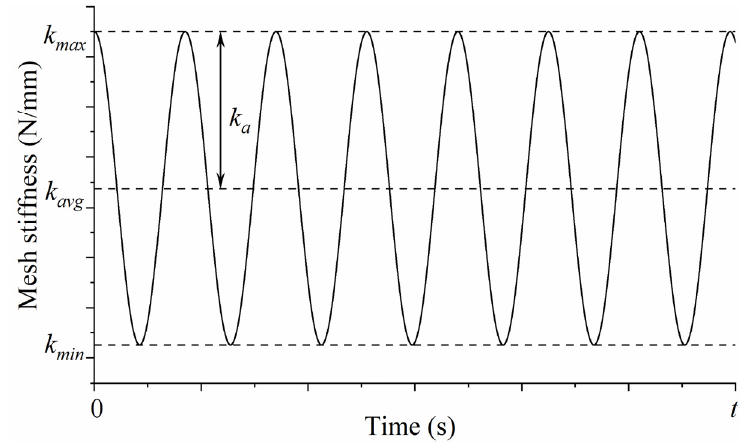
Figure 12. Meshing stiffness of the involute gear.